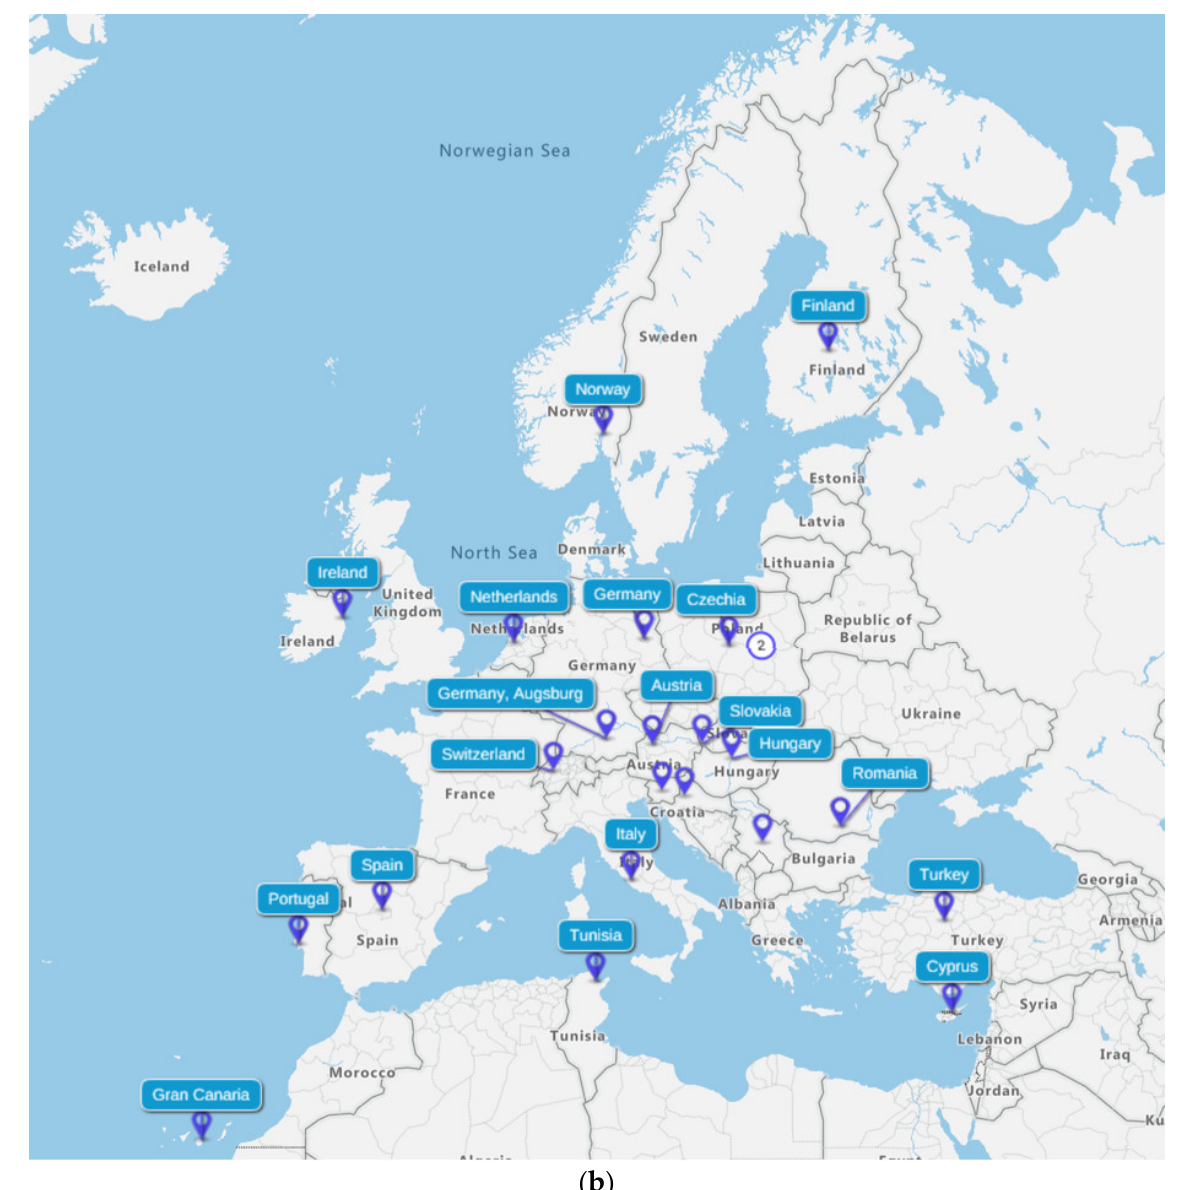
Figure 3. The twenty-five countries covered by the literature ( a ) and detail on Europe ( b ). (Source: eSpatial).